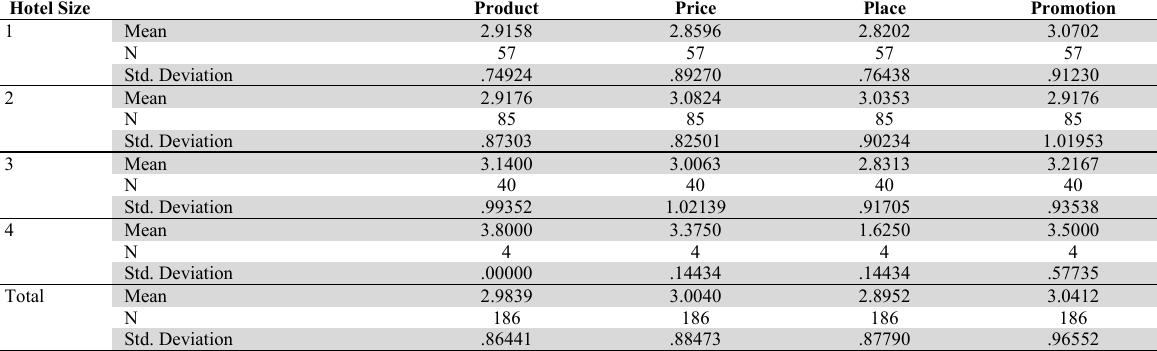
Table 4 Hotel Size with (Product, Price, Place and Promotion)